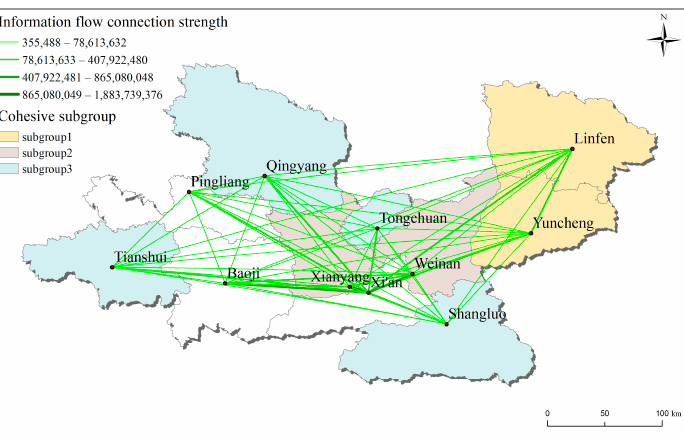
Figure 2. Spatial connection pattern of information flow and analysis results of cohesive